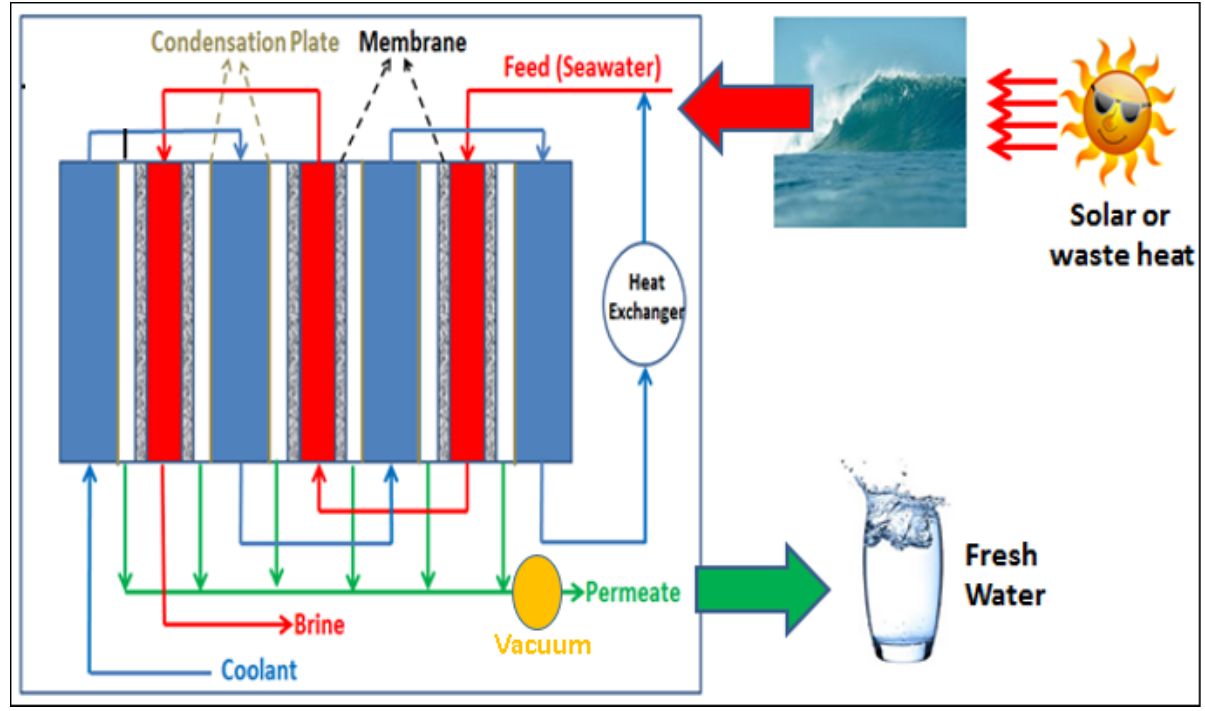
Figure 5. Schematic of a multi ‐ stage VAGMED process.